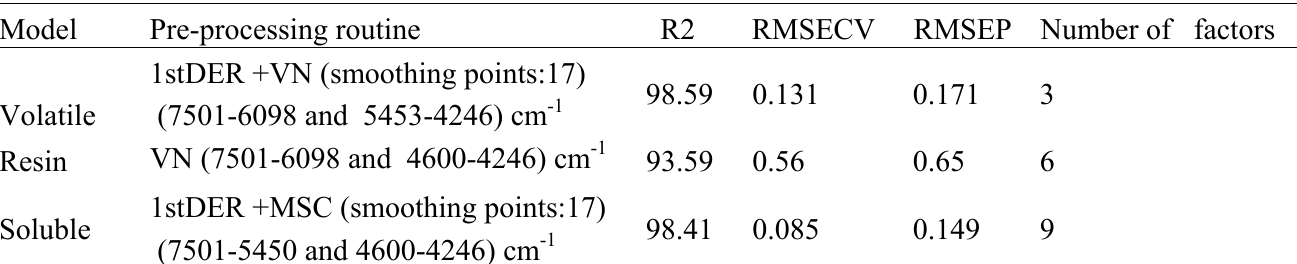
Table 3. R 2 , RMSECV, RMSEP and number of factors for the prepreg quality models using different pre-processing routines.